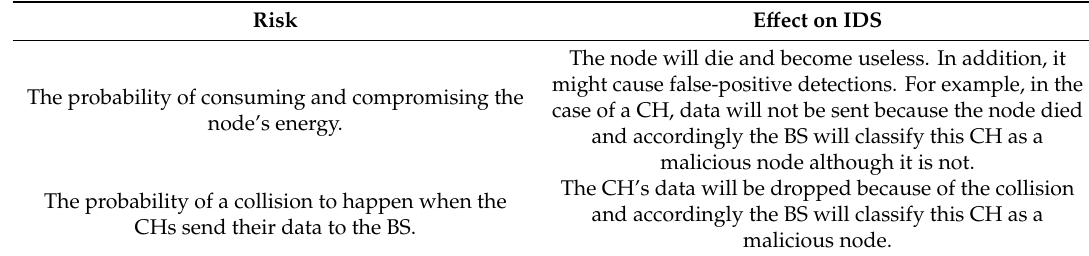
Table 4. Identified